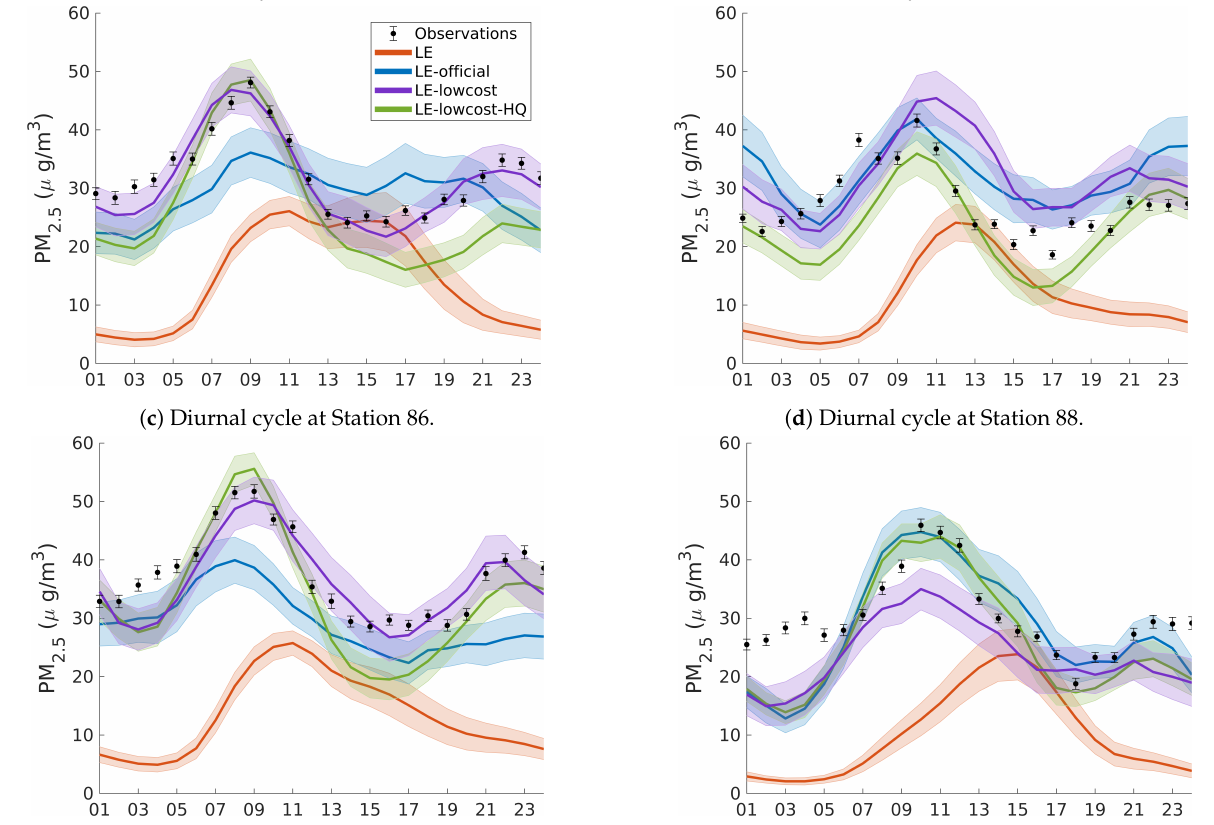
Figure 8. Diurnal cycle of PM 2.5 concentrations from selection stations of the official network ( a )–( d ), LOTOS-EUROS without assimilation, LE-official, LE-lowcost and LE-lowcost-HQ. The bars and the shadows represent the standard deviation over the simulation period. The time stamps are valid for local time